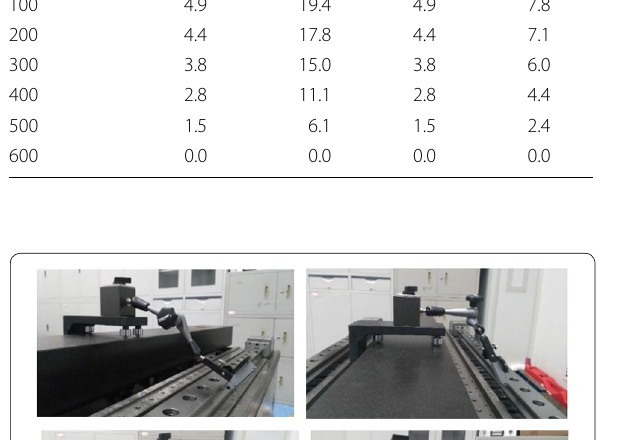
Table 2 Experimental parameters Parameter